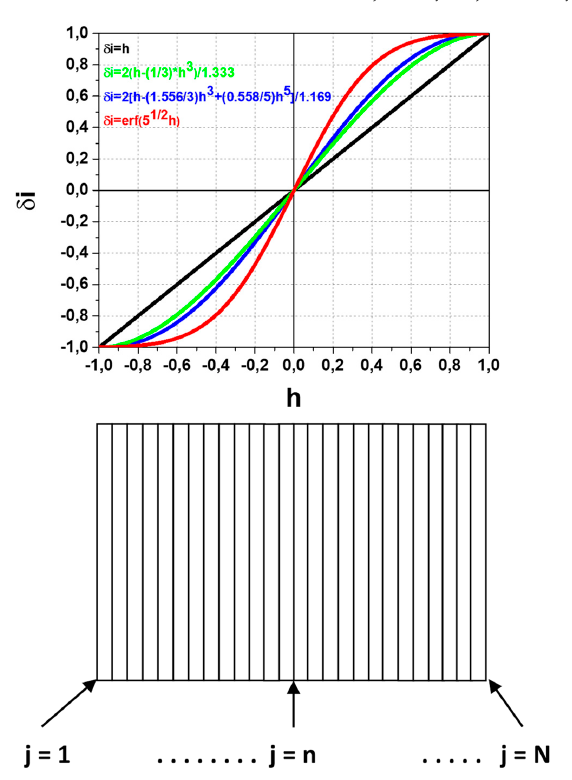
Figure 16. Schematic of multiple cell array detector for secondary beam profile and δ i - h transfer characteristic measurements.